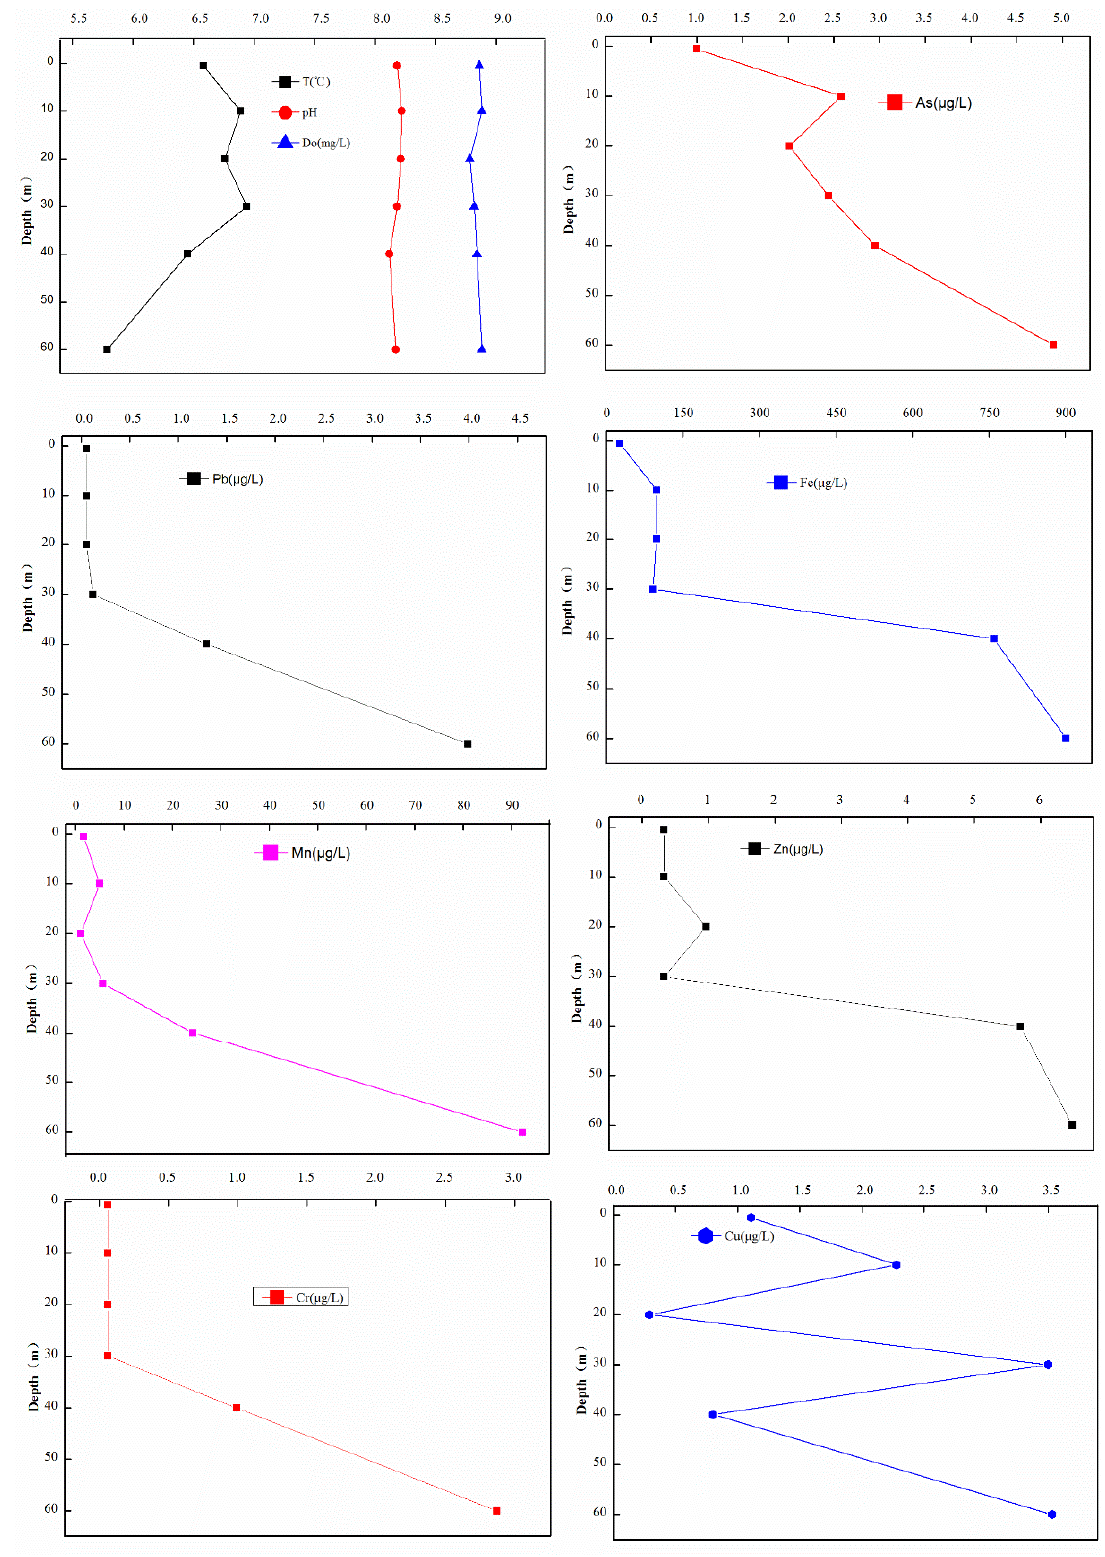
Figure 4. Vertical distribution of physicochemical properties in the water column of the Guoduo reservoir.